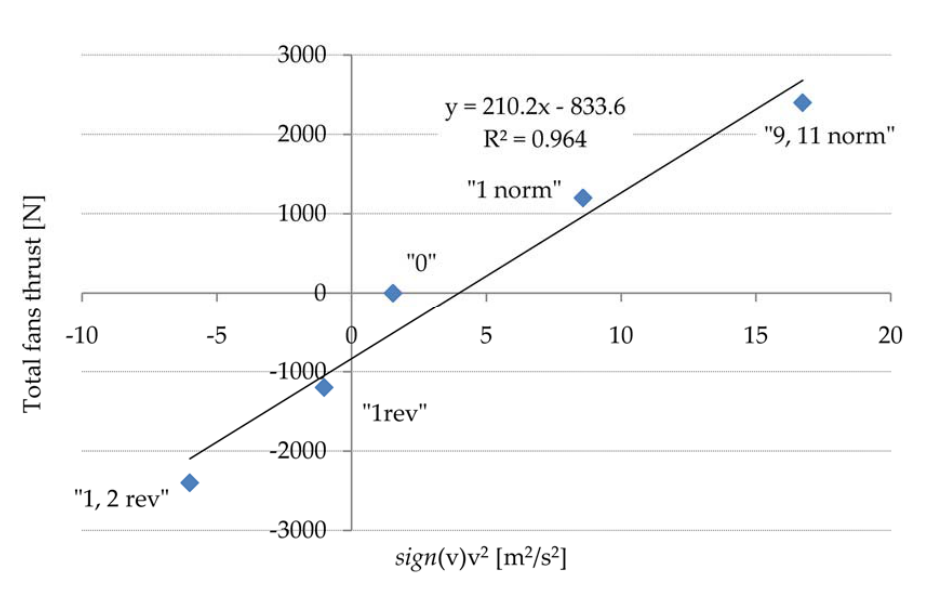
Figure 4. Linear regression F ~ sgn ( v ) v 2 .